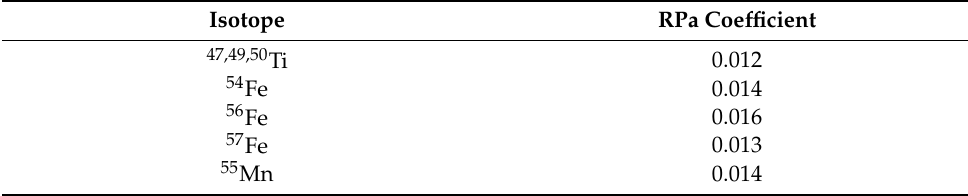
Table 5. RPa coefficients used for the determination of Fe, Mn and Ti, in sediment samples.